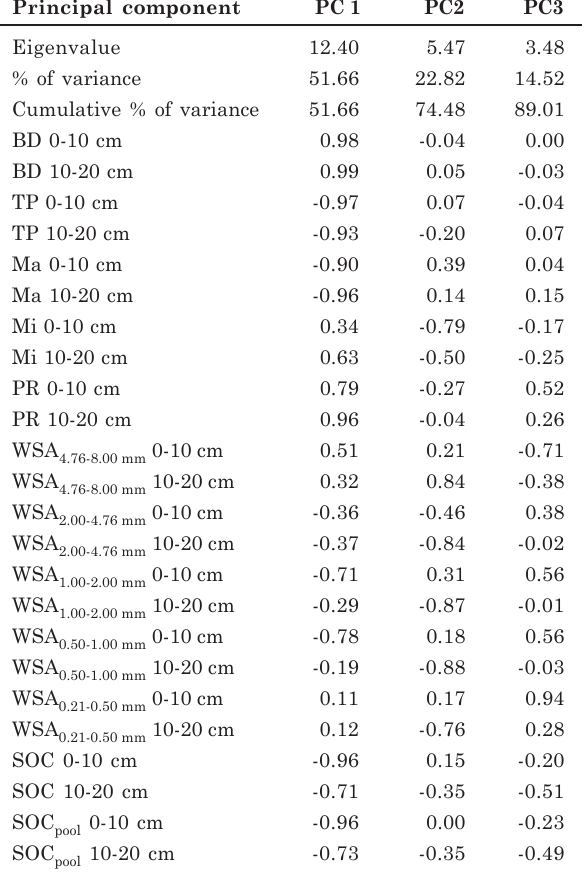
Table 5. Eigenvalues, % variance, cumulative % of variance and correlation between each principal component and soil attributes (bulk density - BD; total porosity - TP; Macroporosity - Ma; Microporosity - Mi; penetration resistence - PR; water stable aggregation - WSA; soil organic carbon -